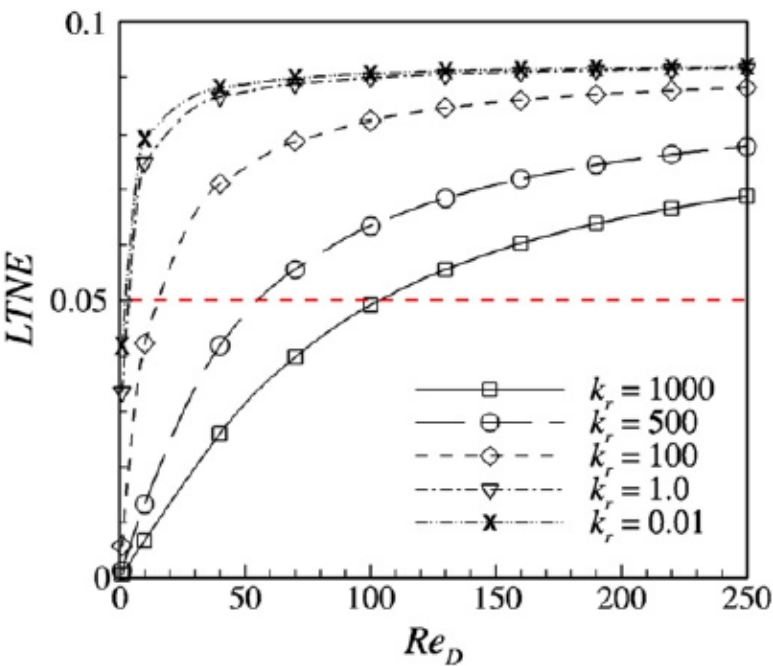
Figure 24. Influence of Reynolds number of a steady non-oscillating flow on the LTNE parameter, for various thermal conductivity ratios, presented by Al-Sumaily et al.